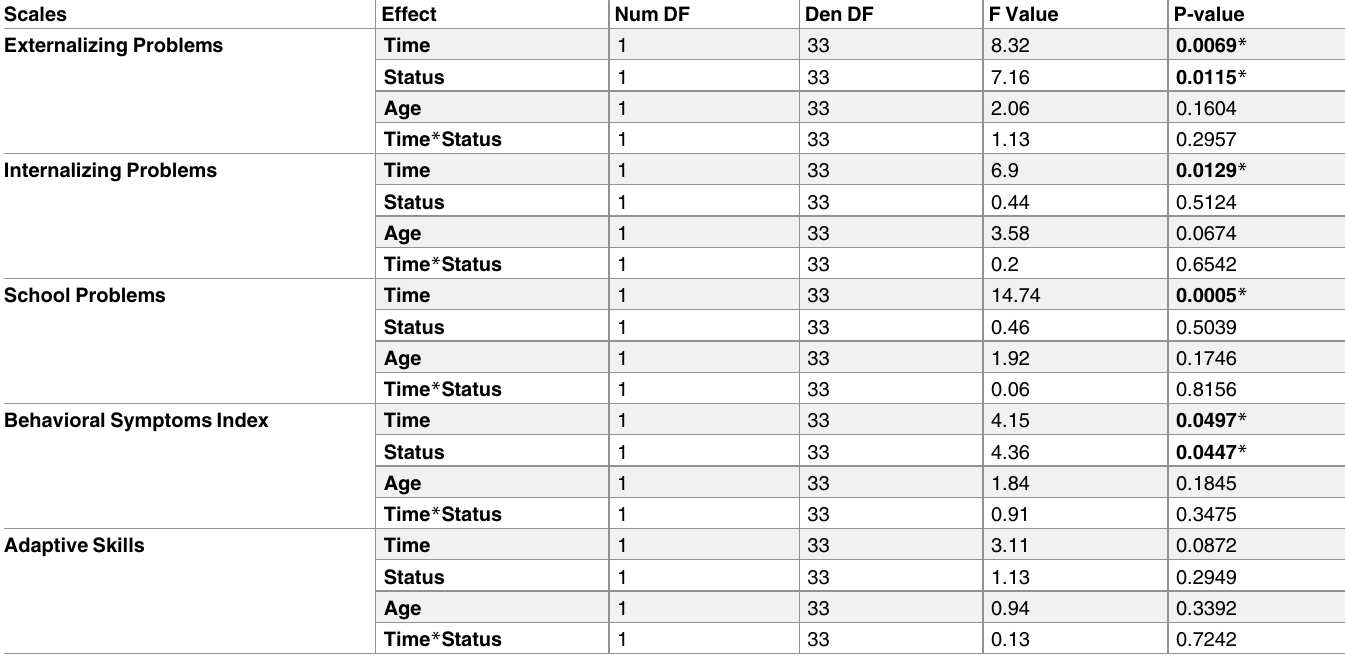
jects’ BASC-2 behavior scores (S2 Table–S5 Table). Effect sizes were determined based on the standardized differences between two groups (i.e. before vs. after treatment), where a calcu- lated effect size of d = 0.2 to 0.49 was considered small; d = 0.5 to 0.79 was considered a medium size effect; and d (cid:21) 0.8 was considered a large effect. By these criteria, when evaluat- ing the effect of treatment on the combined student groups, there was a medium sized benefi- cial effect on externalizing problems and school problems scores. In the egg-positive heavy Table 4. Multiply-adjusted individual effectsof time, egg-positivity status, age, or the interaction of time and infection status on BASC-2 T scores.